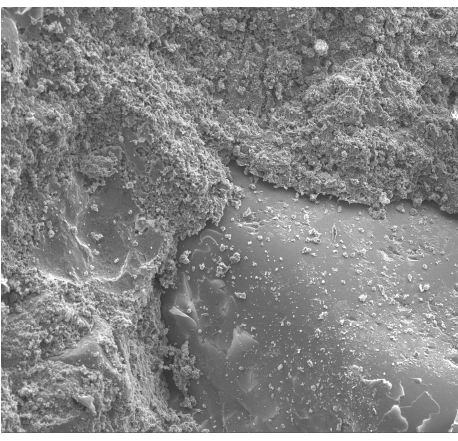
Figure 13. Contact zone of the cement paste with natural sand aggregate at 500× magnification.